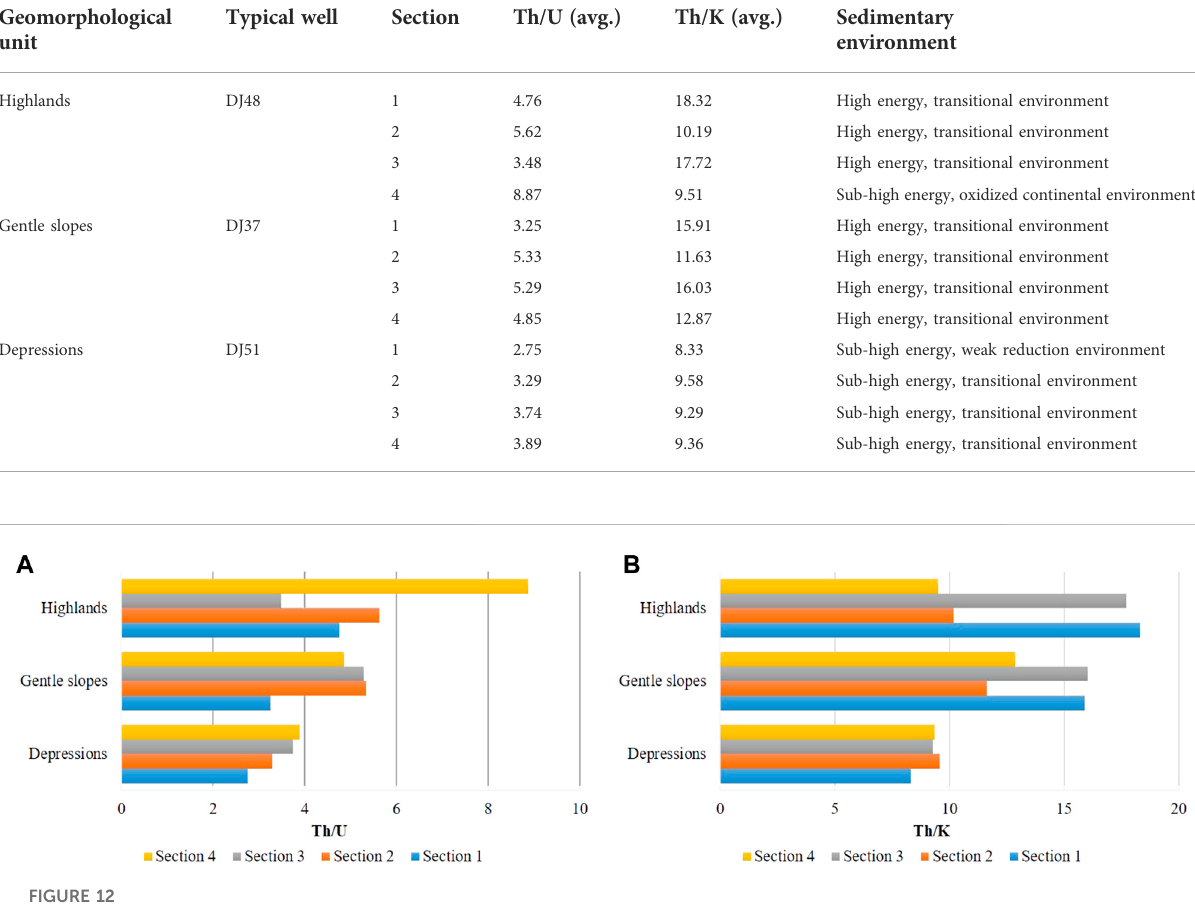
TABLE 3 Natural energy spectrum characteristics and sedimentary environment indications for typical wells in the Shan-2 Lower Sub-member. Geomorphological Typical well Section Th/U (avg.) Th/K (avg.) unit